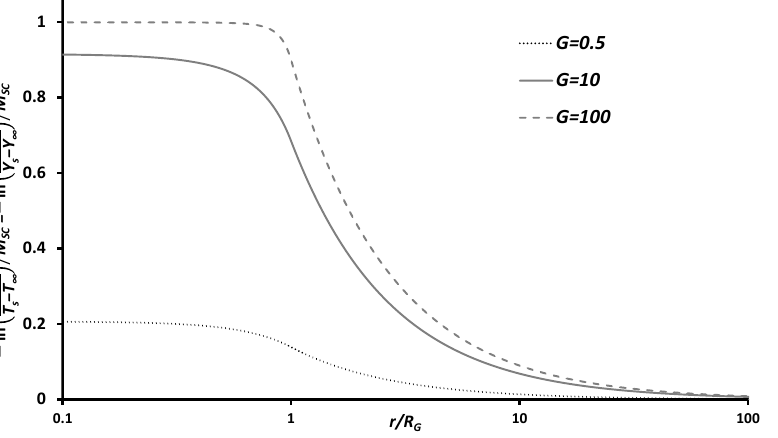
(cid:17) (cid:16) T − T ∞ of the gas and non- T s − T ∞ (cid:16) (cid:17) r of nanoth- R G